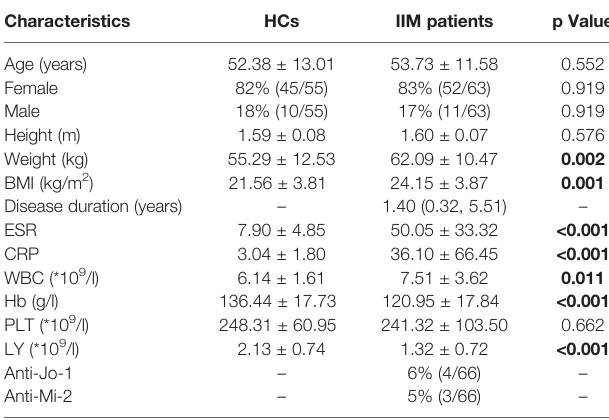
TABLE 1 | Demographic and clinical indicator data of IIM patients and healthy controls (HCs).